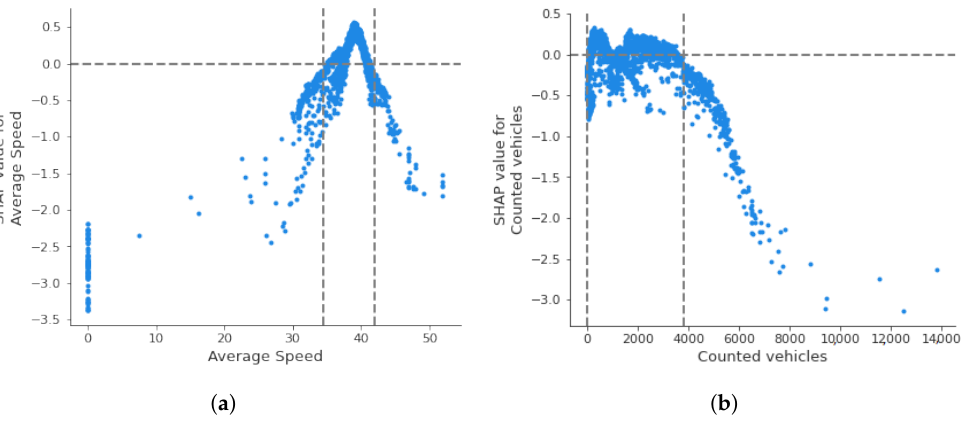
Figure 10. SHAP dependence plots of sensor “MS734”. ( a ) Average speed vs. SHAP values. ( b ) Traffic flow vs. SHAP